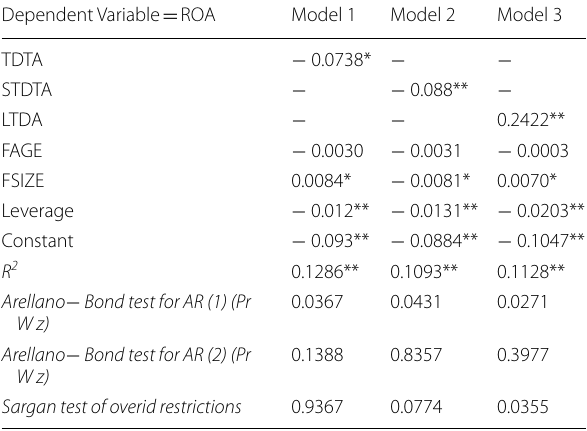
*Indicates Significance level 0.05 and ** Indicates Significance level 0.01